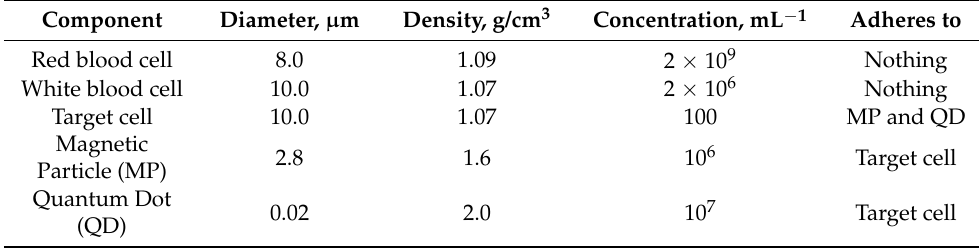
Table 1. Properties of cells, particles and quantum dots used in